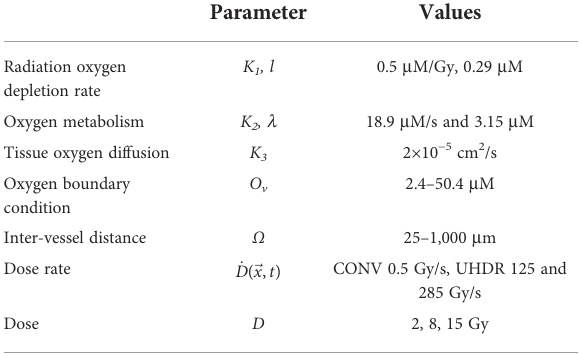
TABLE 1 Parameters used in solving PDE Eq. ( 1 )